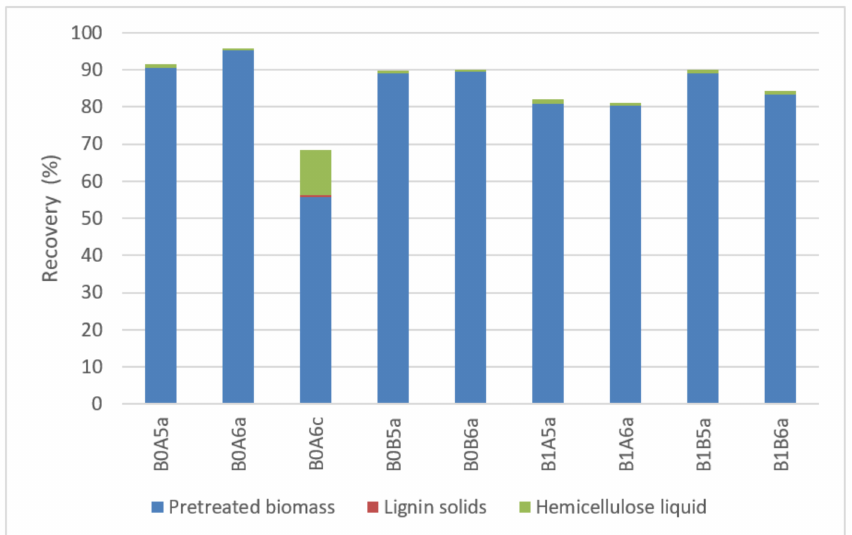
Figure 3. Cellulose distribution in the different fractions. Representation of the codes: 0— pretreatment at 200 ◦ C; 1—pretreatment at 180 ◦ C; A—pretreatment time of 15 min; B—pretreatment of 30 min; 5—50% v / v ethanol content; 6—60% v / v ethanol content; a—no catalyst added; c—1% w / w biomass H 2 SO 4